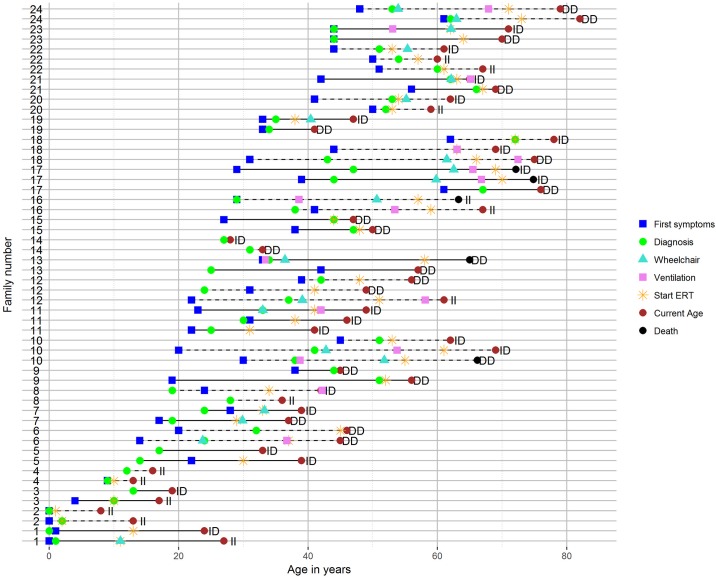
ACE polymorphisms and clinical parameters in family members with Pompe disease.Each line represents one patient. Families are numbered and visualized using alternating straight and dotted lines. The ACE genotype of individual patients is indicated at the right side of each patient’s line. Onset of clinical events is plotted on the X axis and indicated with the symbols indicated on the right.